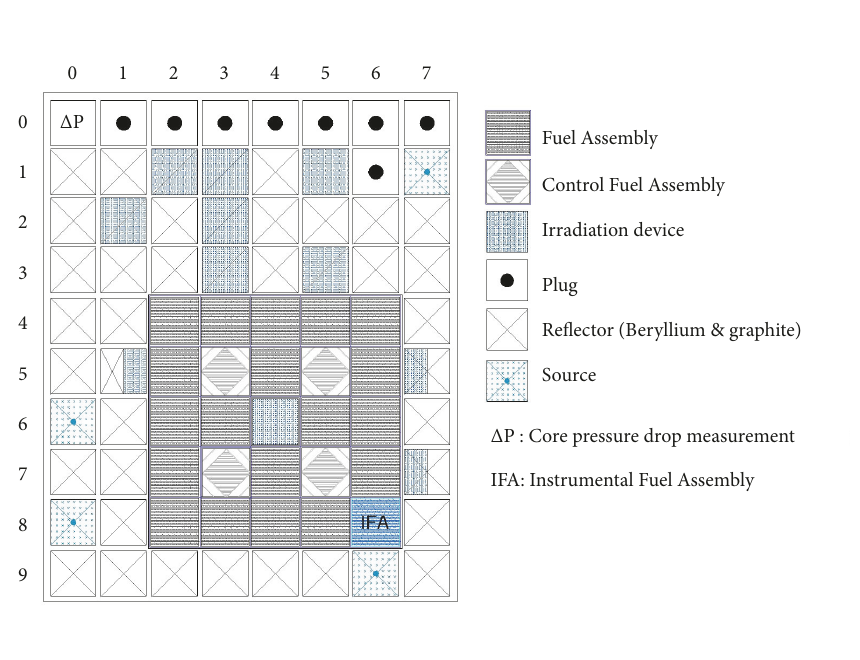
Figure 5: Top view of configuration 243 of the IEA-R1 nuclear core. Adapted from